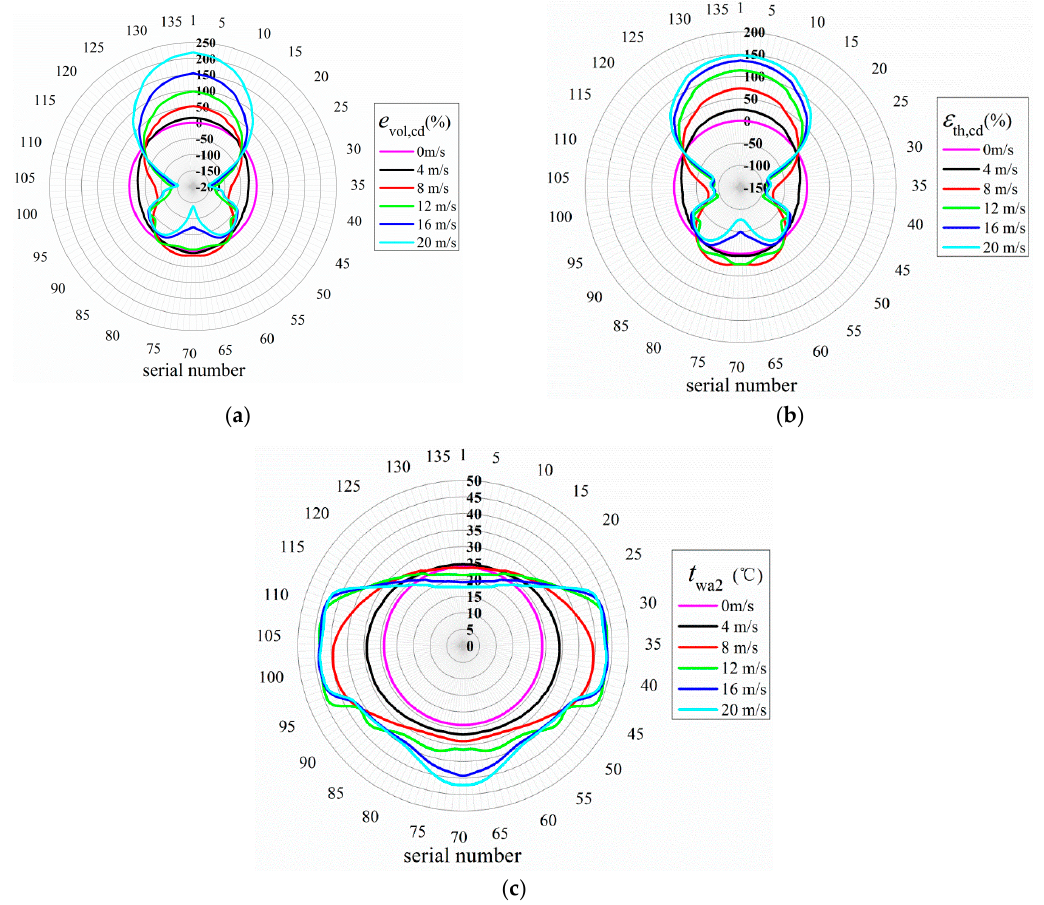
Figure 10. Performance distributions for case A. ( a ) Volume effectiveness; ( b ) Thermal efficiency; ( c ) Outlet water temperature.